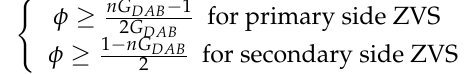
is the sum of the battery voltages v B1 and v B2 . For the voltage balance loop, individual phase-shift modulation is used to manage the unbalanced power between the battery modules with its own feedback voltage loop of v B1 and v B2 . In addition, the control signals have a 180-degree phase shifted to improve the input current waveforms contributed by each converter module.